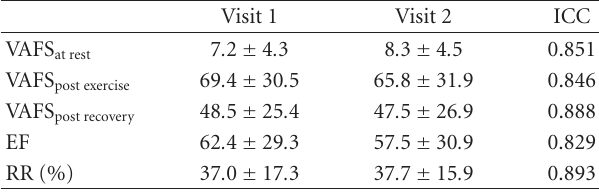
Table 2: The intraclass correlation coe ffi cient of measures on 2 separate visits ( n =